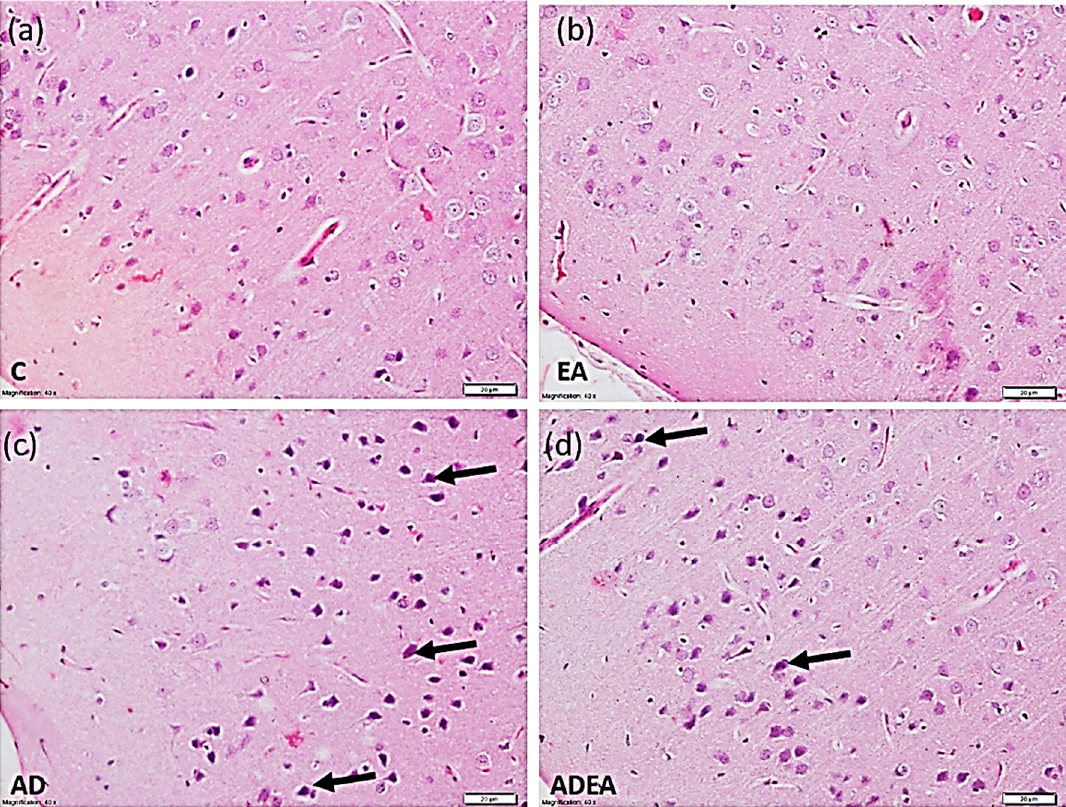
Figure 3. Photomicrograph showing the normal architectural pattern of the ERC with neurons having vesicular pale nuclei in the control ( a ) and EA ( b ) groups. In the AD ( c ) group, the ERC exhibited disturbed architecture, and neurons with condensed deeply stained pyknotic nuclei (arrows). In the ADEA ( d ) group, most neurons were restored with clear vesicular nuclei among a few scattered hyperchromatic condensed nuclei (arrows). (H&E, magnification ×40, scale bar 20 µm).